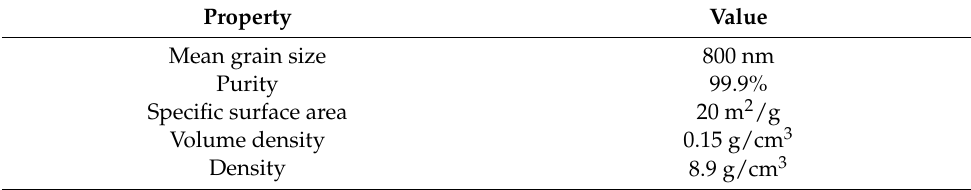
Table A2. The properties of SiC particles.